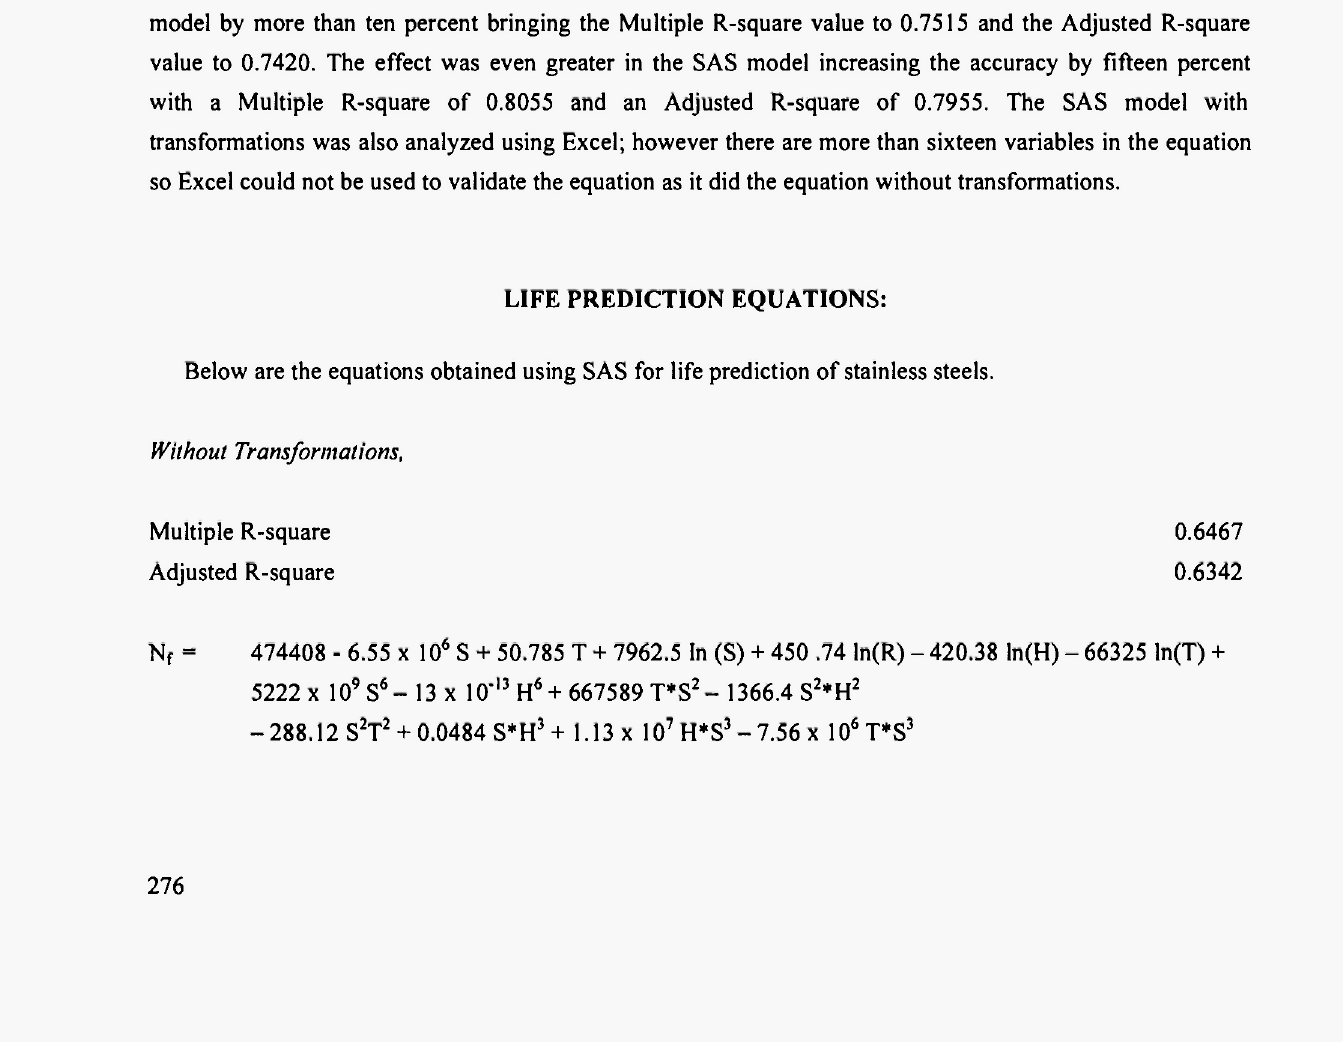
Without Transformations,